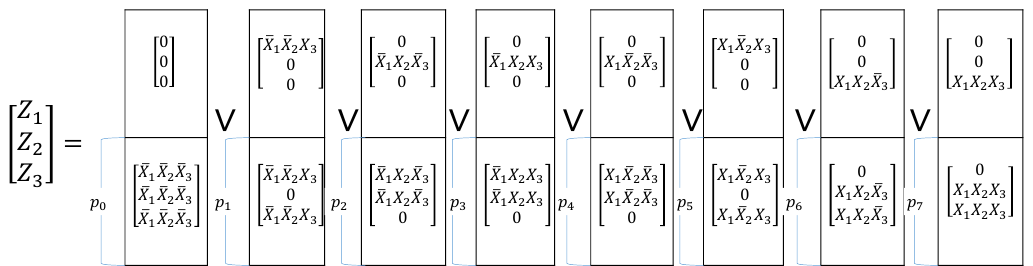
Fig. 5. A display of all 256 particular solutions of Example 1 as a disjunction of possible contributions of